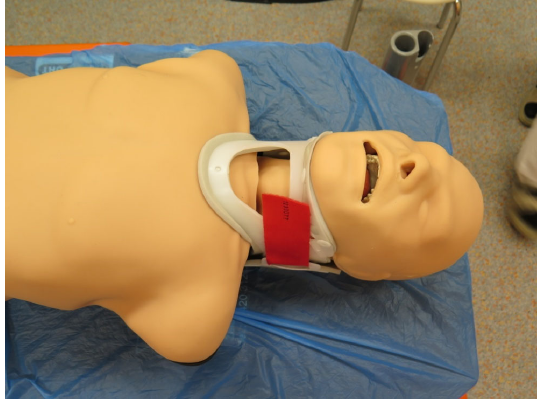
Figure 1. Truman manikin with the neck immobilized using the cervical collar.